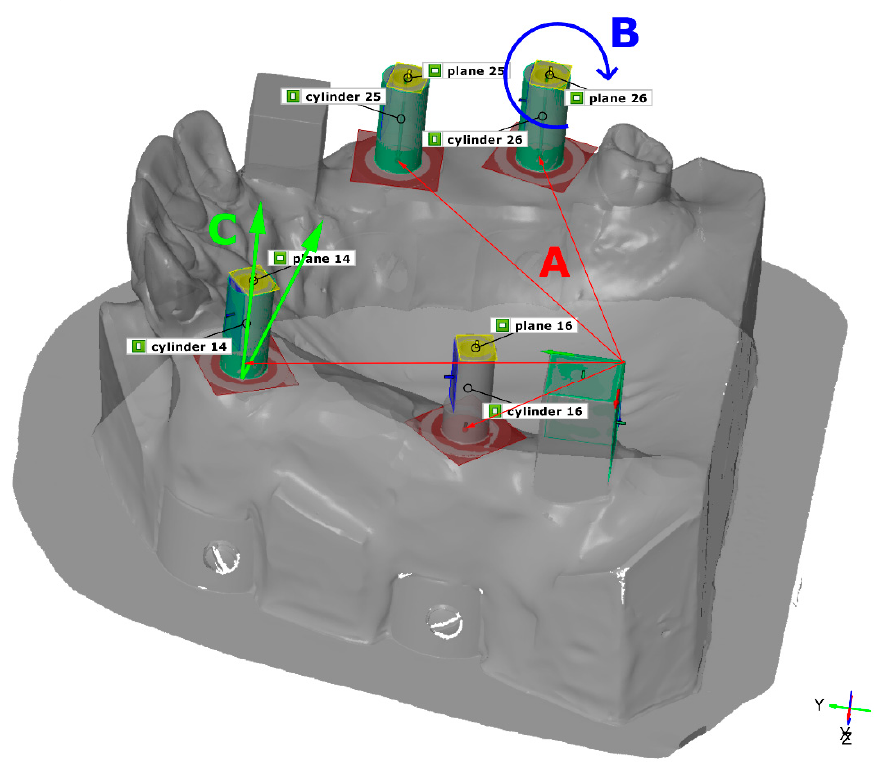
Figure 2. Schematic representation of the measured absolute three-dimensional distances ( A ), rota- tions ( B ), and angulations ( C ) within the implant master model (IMM). rotations ( B ), and angulations ( C ) within the implant master model